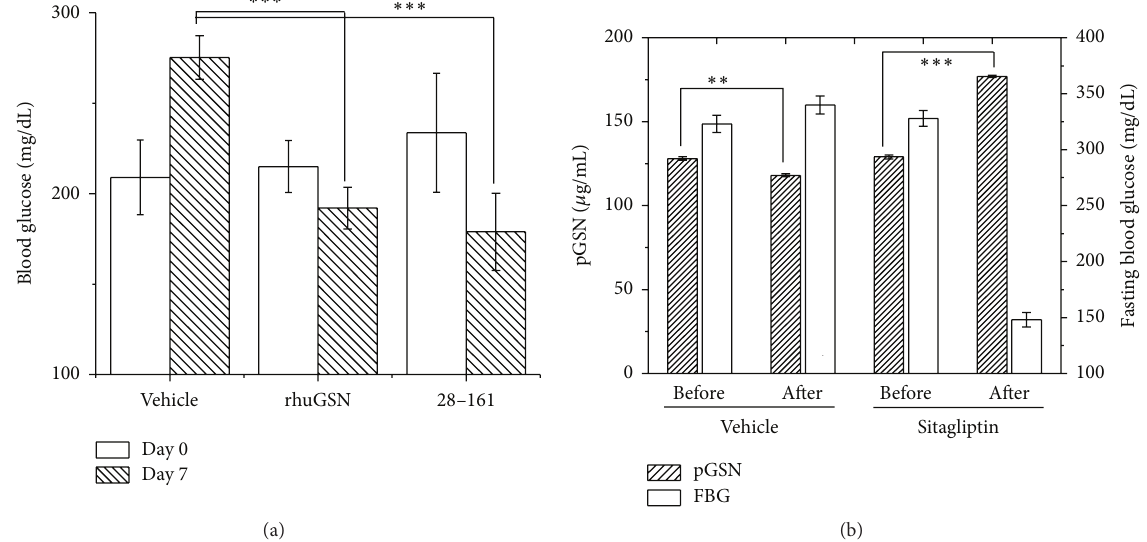
Figure 3: (a) Blood glucose levels on day 0 and day 7 in high fat diet and Streptozotocin induced (HFD/STZ) C57BL/6 diabetic mice treated with daily doses of PBS, rhuGSN, and 28–161 have been plotted here. (b) Variation in measured fasting blood glucose values and pGSN levels in diabetic mice ( 𝑁 = 10 ) before and after daily treatment with antihyperglycemic drug for two weeks has been plotted here. 𝑃 values are as mentioned in Methods (Section